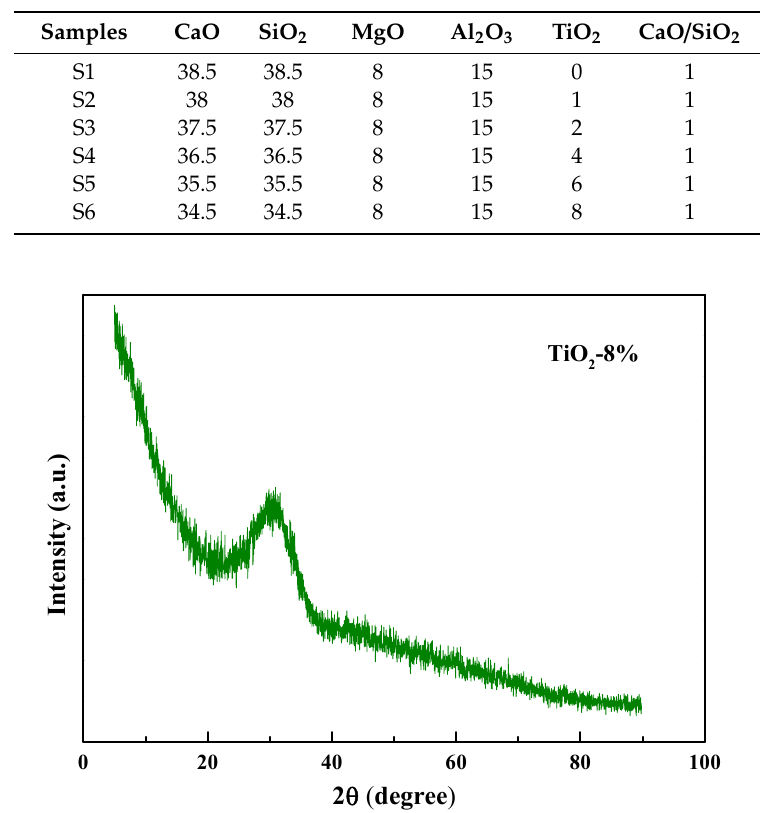
Figure 1. X-ray di ff raction (XRD) pattern of the quenched sample with 8% TiO 2 Figure 1. X ‐ ray diffraction (XRD) pattern of the quenched sample with 8% TiO 2 .